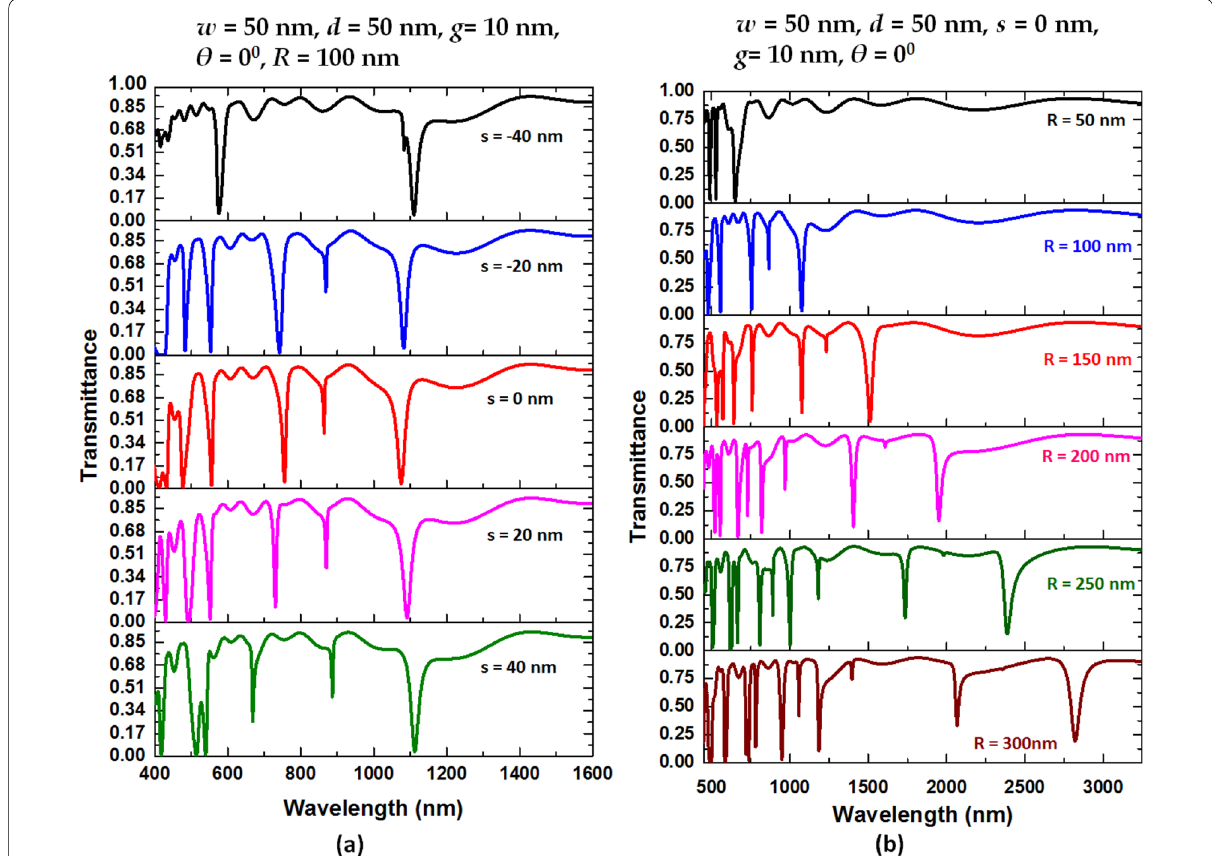
Fig. 6 Transmission spectra versus a s variation and b R variation of the case 3